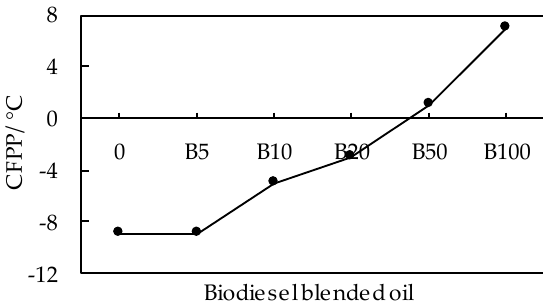
Figure 5. E ff ects of blending ratio of biodiesel blended oil on CFPP (cold filter plugging point).